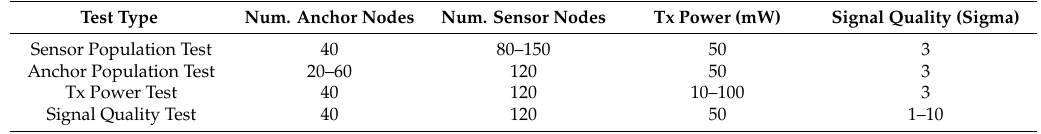
Table 1. Simulated system parameters used in different